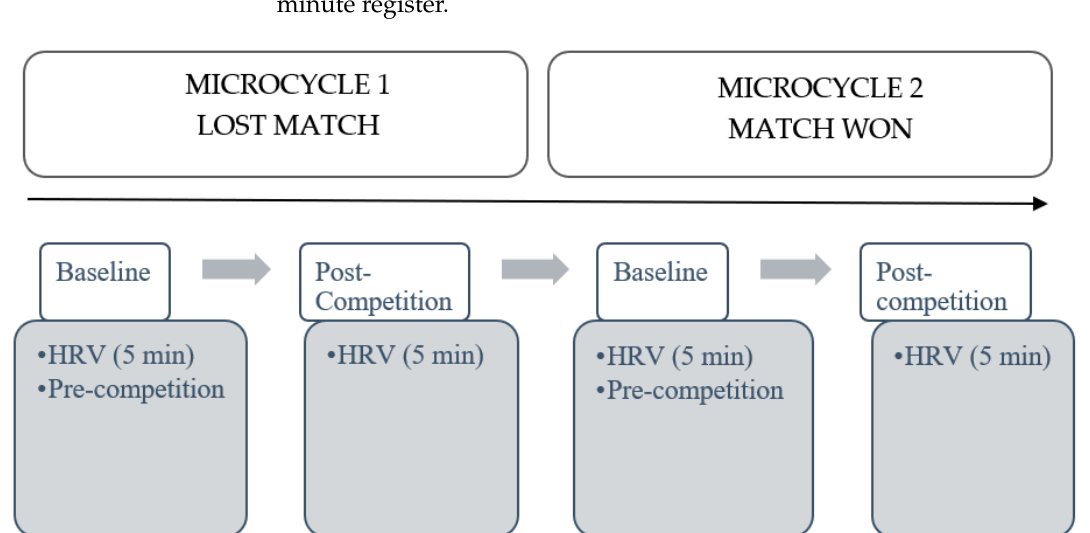
Figure 1. Study procedure timeline. HRV: Heart rate variability.